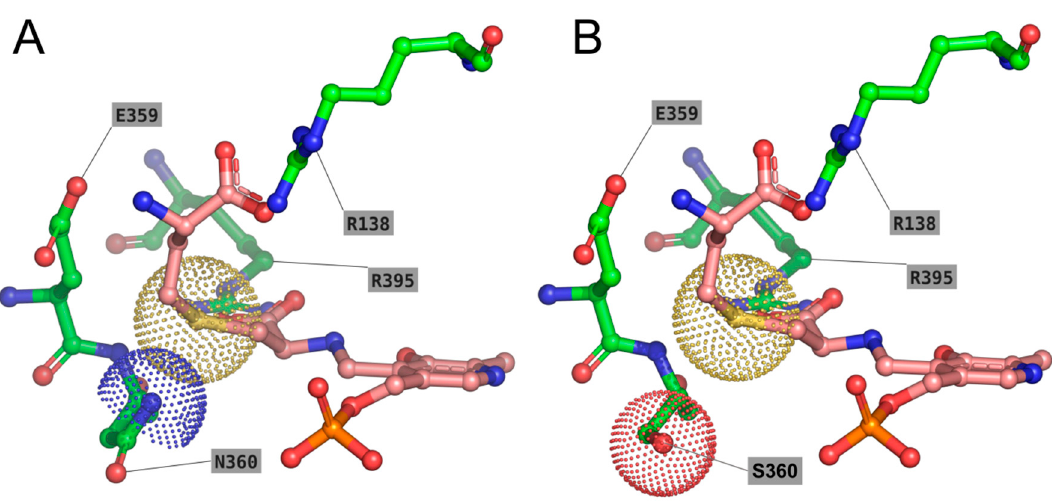
Figure 7. Modelling of the external aldimine of PLP- L -cth in complex with wild type TgCGL ( A ) and N360S mutant TgCGL ( B ). The external aldimine of PLP- L -cth is shown as pink sticks, and the surrounding residues as green sticks. Residues described in text are labeled in single-letter code. The Van der Waals radius of the S γ atom of L -cth is shown as yellow dots. The Van der Waals radii of N γ N360 and O β S360 are shown as blue and red dots, respectively.